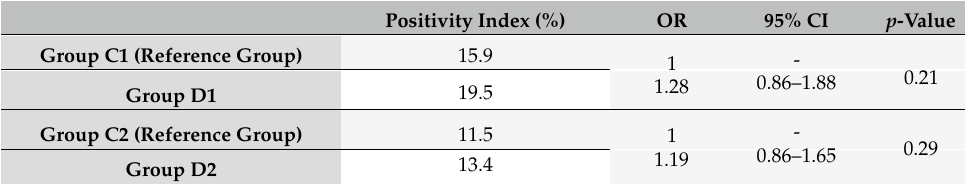
Table 4. Positivity indexes and odds ratios for subjects tested for